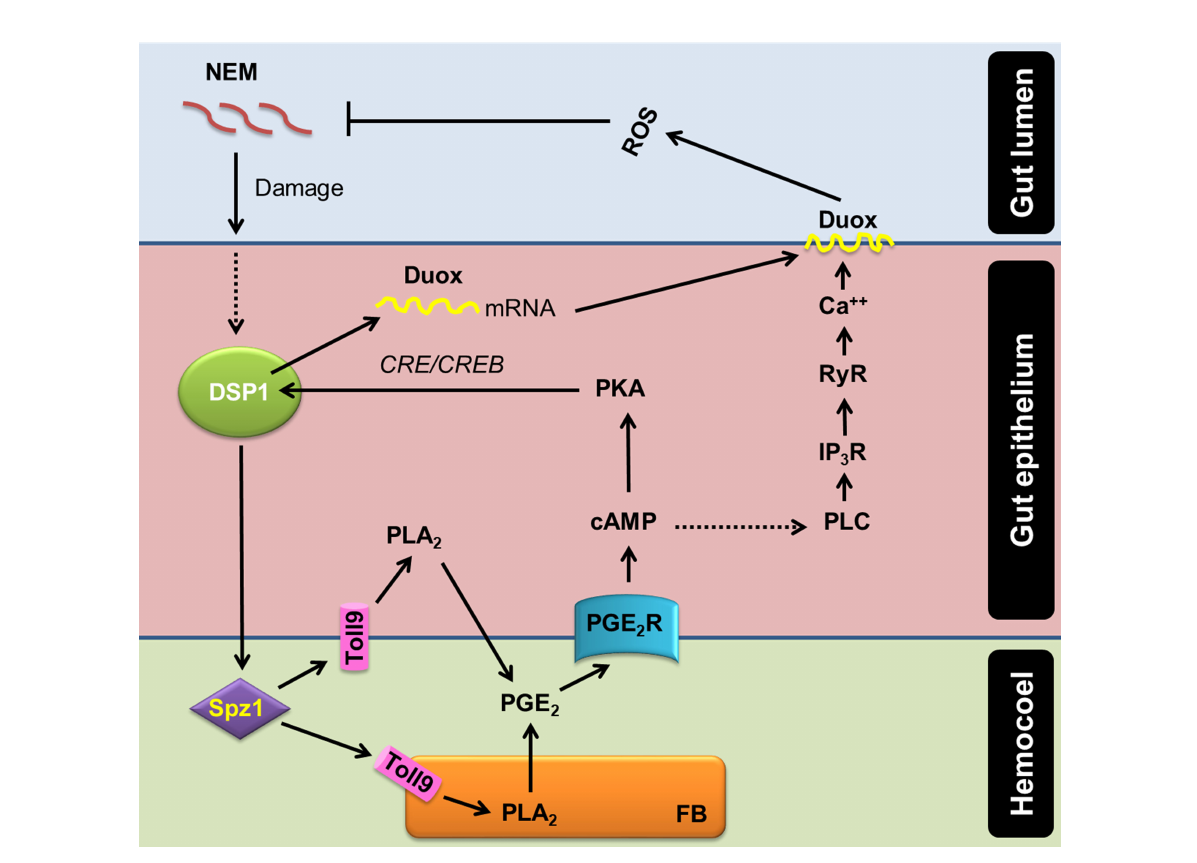
FIGURE 7 A model of PGE 2 mediating DSP1/Ca 2+ /Duox signaling pathway in the midgut epithelium of S . exigua in response to an entomopathogenic nematode ( ‘ NEM ’ ) infection. Upon infection of gut epithelium by EPN, a damage-associated pattern molecule ( ‘ DSP1 ’ ) is released to hemocoel. Released DSP1 binds to spätzle 1 ( ‘ Spz1 ’ ) to activate the Toll9 receptor to produce PGE 2 in the gut epithelium or fat body ( ‘ FB ’ ) by activating phospholipase A 2 ( ‘ PLA 2 ’ ) [20]. The autocrine/paracrine PGE 2 binds to its speci fi c receptor ( ‘ PGE 2 R ’ ) to up-regulate cAMP, which triggers Se- Duox expression via PKA/CREB [15]. cAMP also activates phospholipase C ( ‘ PLC ’ ) to increase the inositol triphosphate ( ‘ IP 3 ’ ) level [19]. IP 3 binds to its receptor ( ‘ IP 3 R ’ ) on the endoplasmic reticulum to release Ca 2+ [19]. The released Ca 2+ triggers calcium-induced calcium release from the ryanodine receptor ( ‘ RyR ’ ), which leads to a Ca 2+ burst [19]. The up-regulated Ca 2+ then activates dual oxidase ( ‘ Duox ’ ) to produce reactive oxygen species ( ‘ ROS ’ ) and fi nally defend